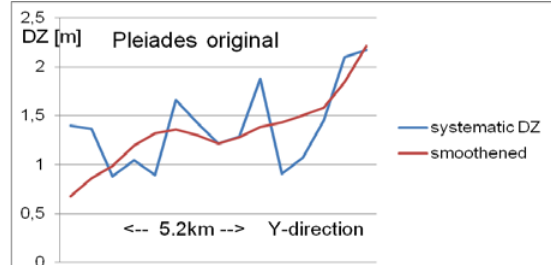
Figure 12. Systematic height errors in Y-direction, Zonguldak,